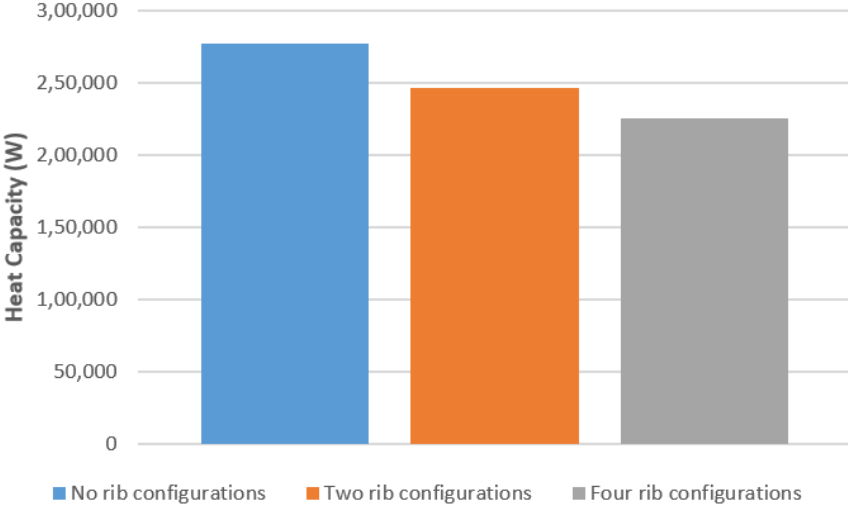
Figure 16. The comparison of heat capacity of different rib configuration.